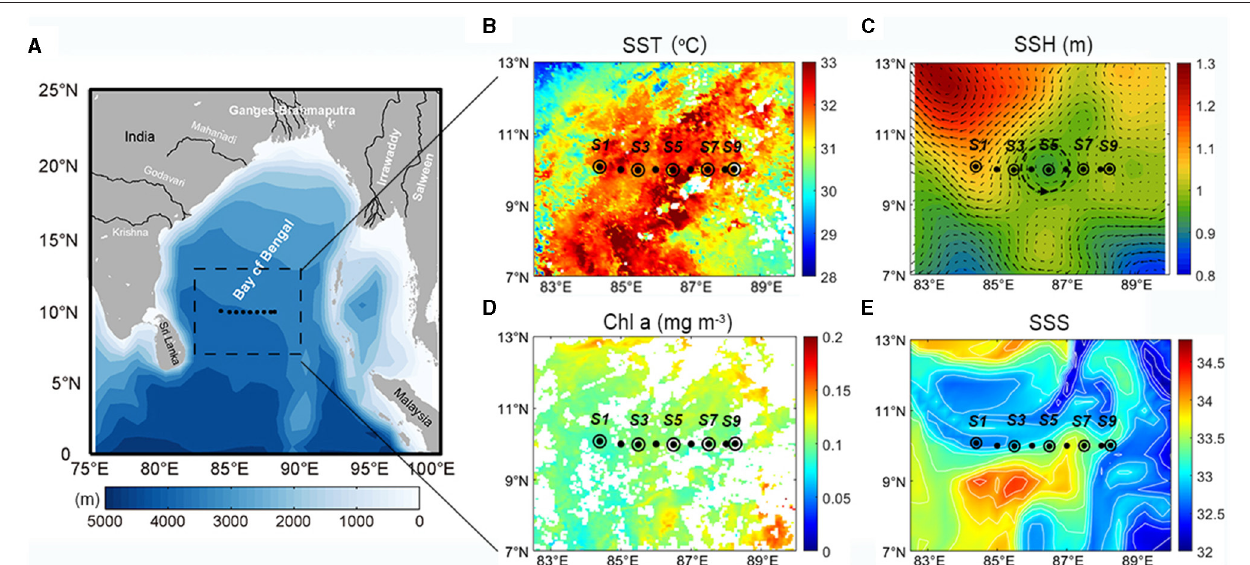
FIGURE 1 | (A) Bathymetry, (B) MODIS sea surface temperature (SST, ◦ C), (C) AVISO sea surface height (SSH, m) with geostrophic currents (m s − 1 ), (D) MODIS sea surface Chl a (mg m − 3 ), and (E) CMEMS modeling sea surface salinity (SSS) in the study region. The dots in black indicate CTD sampling stations, while black circles are additional chemical and biological